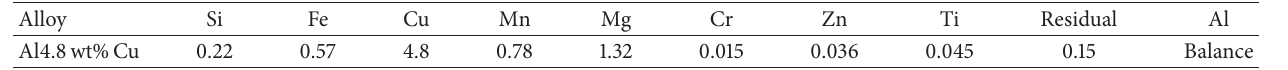
Figure 1: DTA results. (a) Example of the result obtained for the alloy with 0.23 wt% of Cu and (b) pseudobinary phase diagram of Al alloy recycled with Cu addition. Table 1: Chemical composition of Al4.8 wt% Cu produced from aluminium cans